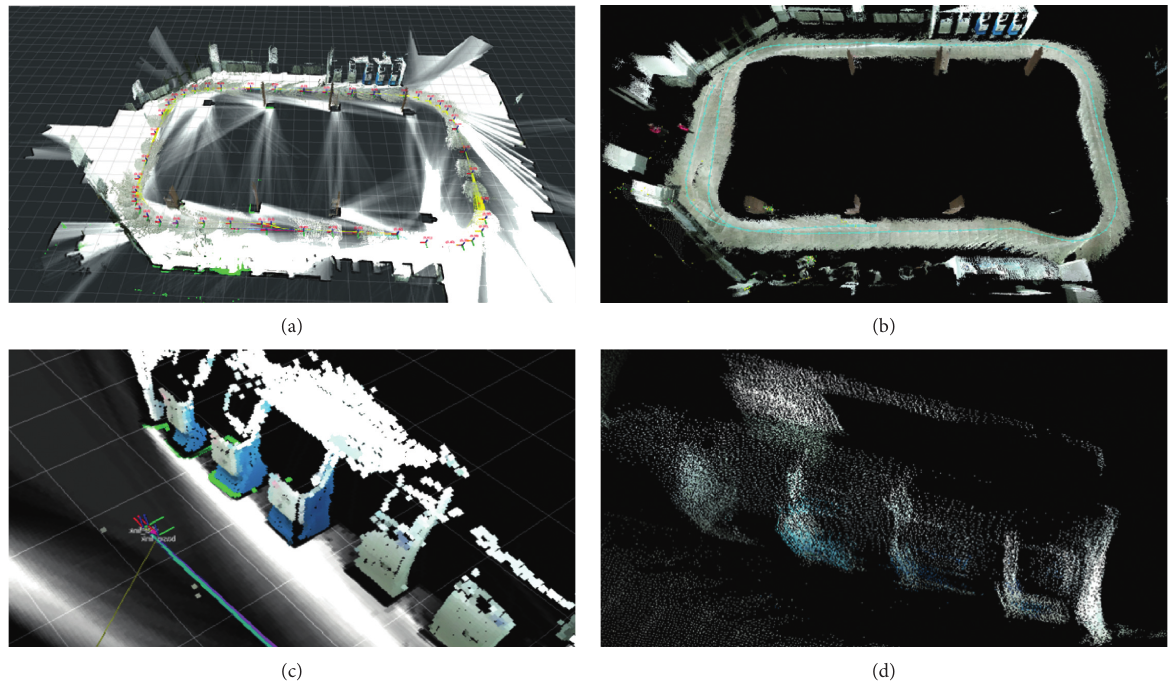
Figure 11: Comparison of the mapping effect on the first floor. (a), (b) The mapping effect of our proposed algorithm and RTAB, respectively. (c), (d) Enlarged details of the algorithm results.